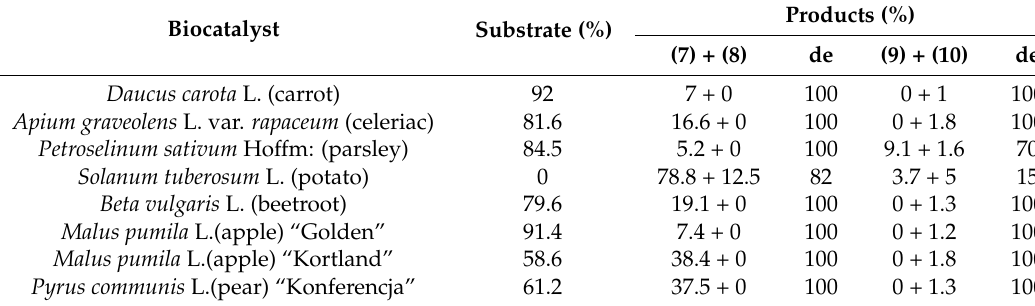
Table 4. Results of the biotransformation of (4 S )-(+)-carvone ( 6 ). Biocatalyst Substrate (%) Apium graveolens L. var. rapaceum